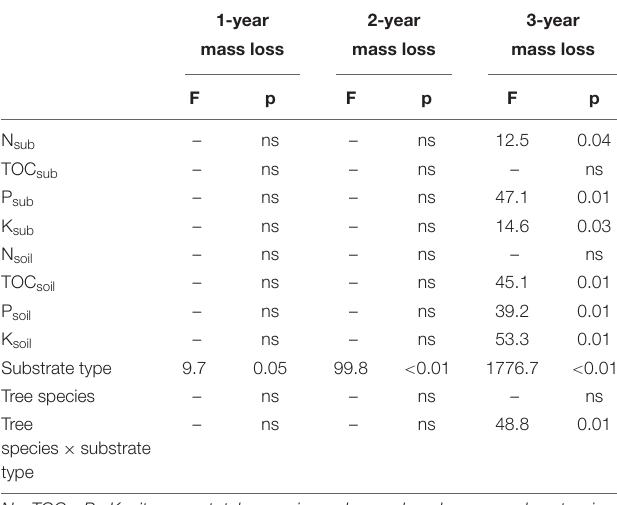
TABLE 4 | Analysis of covariance of the pooled fine roots and needle litter mass loss ( N = 15) after 1, 2, and 3 years, initial substrate and soil